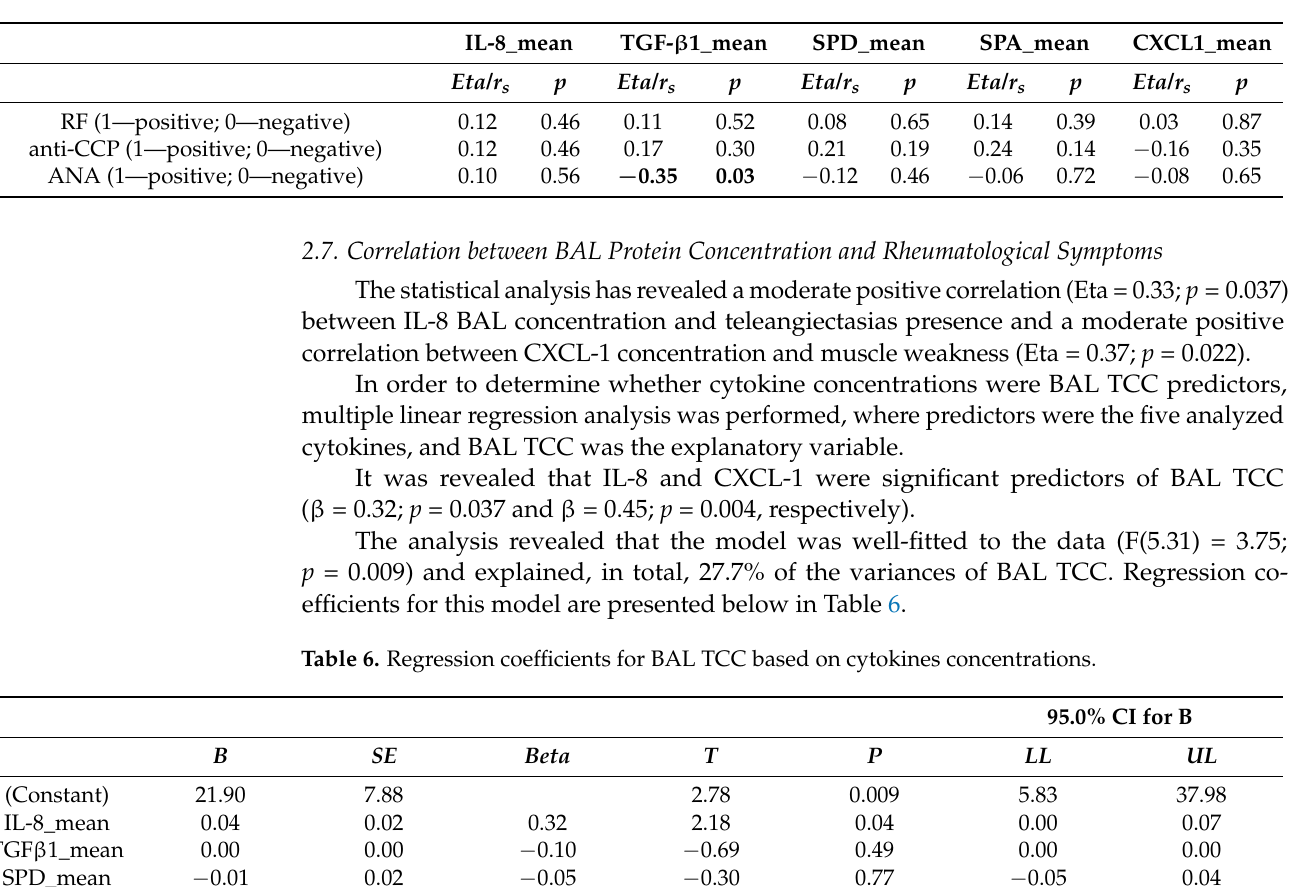
Table 5. Correlation between BAL protein concentration and autoantibodies presence.